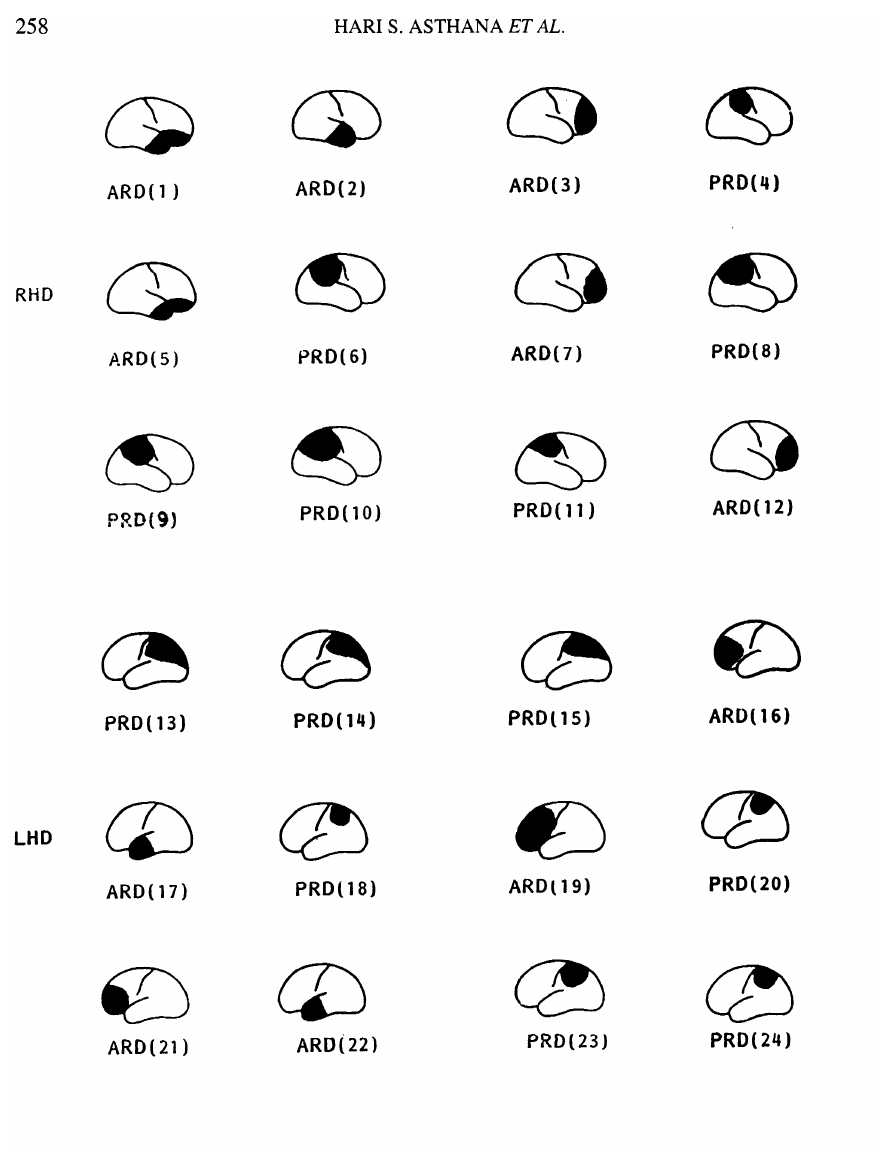
FIG. 1. Location and size of lesions based on CT and operation findings (refer Table I for subject number shown in parenthesis); RHD (right hemisphere damage), LHD (left hemisphere damage), ARD (anterior regional damage), PRD (posterior region damage). Two patients (no. 9 in RBD group and no. 23 in LHD group) were dropped from the region-wise